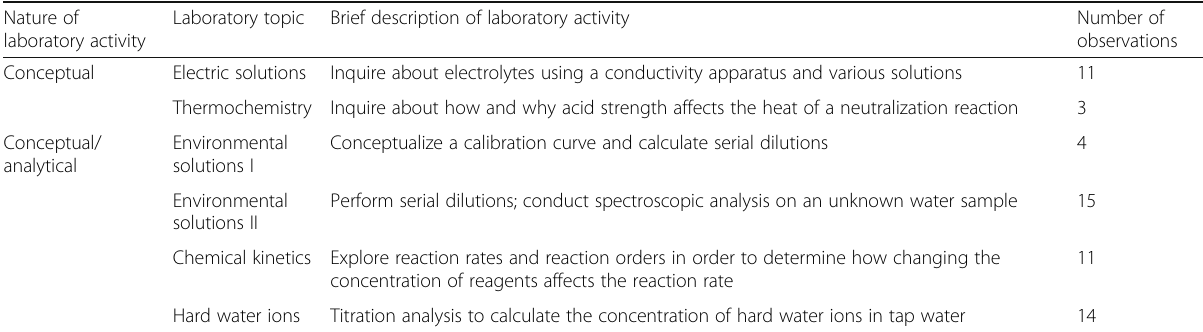
Table 1 Description of chemistry laboratory activities